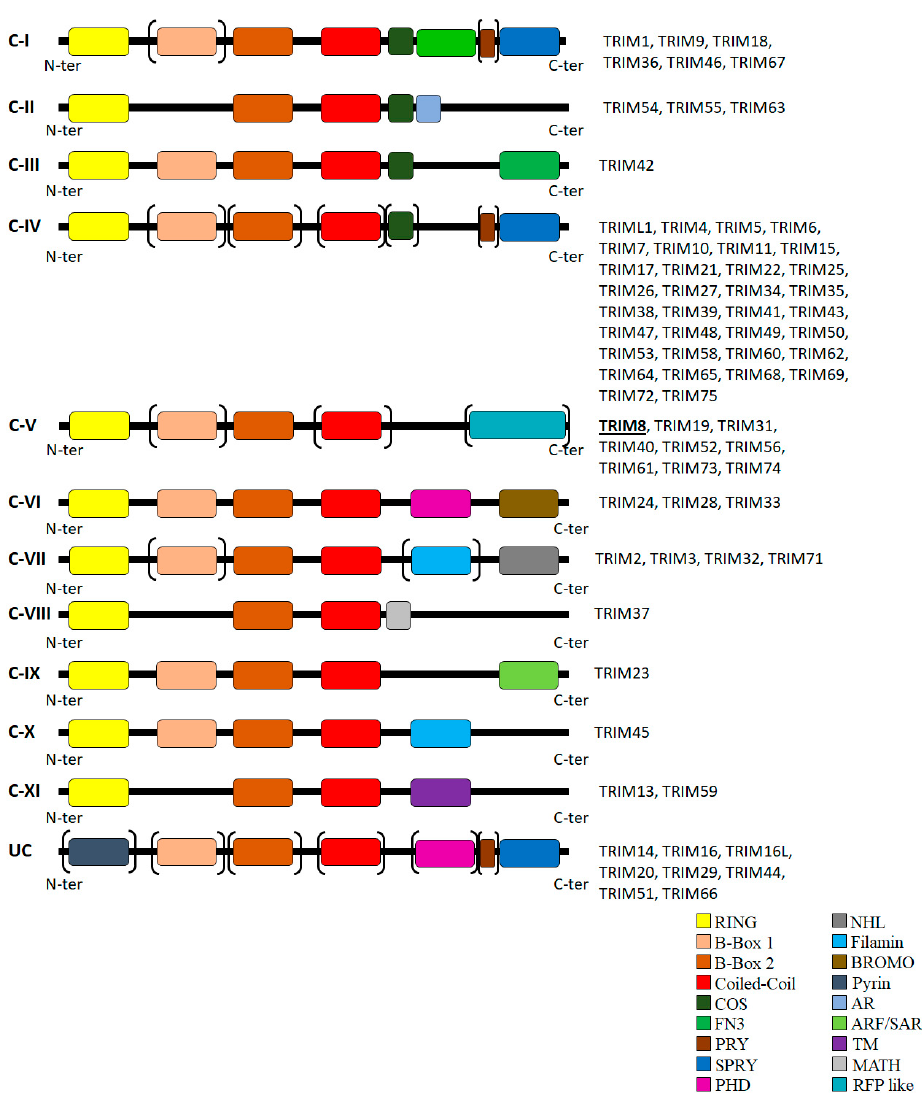
Figure 1. Classification of human TRIM proteins. The TRIM protein family is composed of 11 sub-families, from C-I to C-XI. Some of the TRIM proteins remain unclassified (UC), since they do not have a RING finger domain, unlike the classified TRIM proteins. Additional domains are: NHL: NHL repeats; COS: COS box motif; FN3: fibronectin type III motif; PHD: plant homeodomain; BROMO: